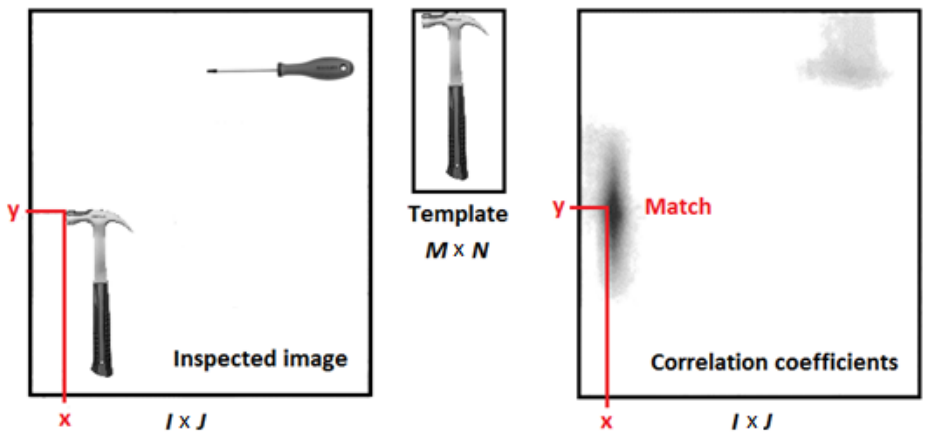
Figure 8. Cross-correlation between image and pattern.